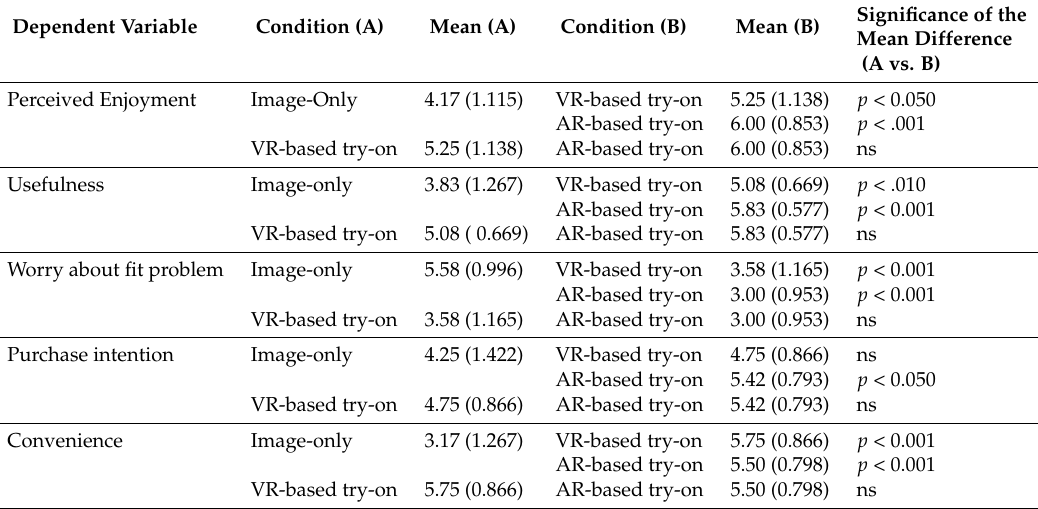
Table 2. Post-hoc between-group results.